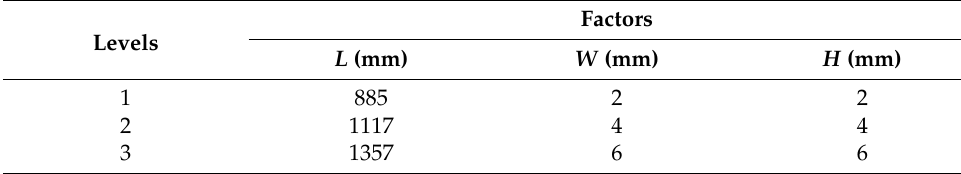
Table 4. Factors and levels of the orthogonal